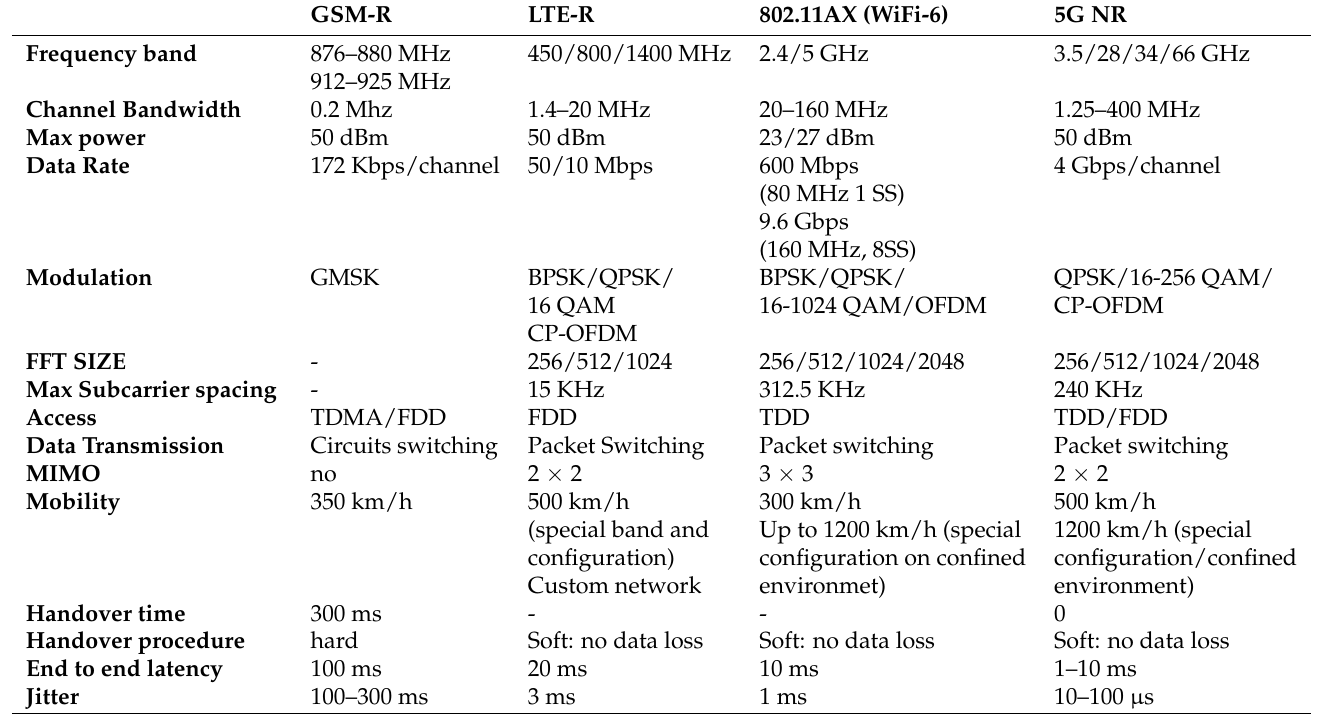
Table 1. Specifications of communications for critical/performance and business